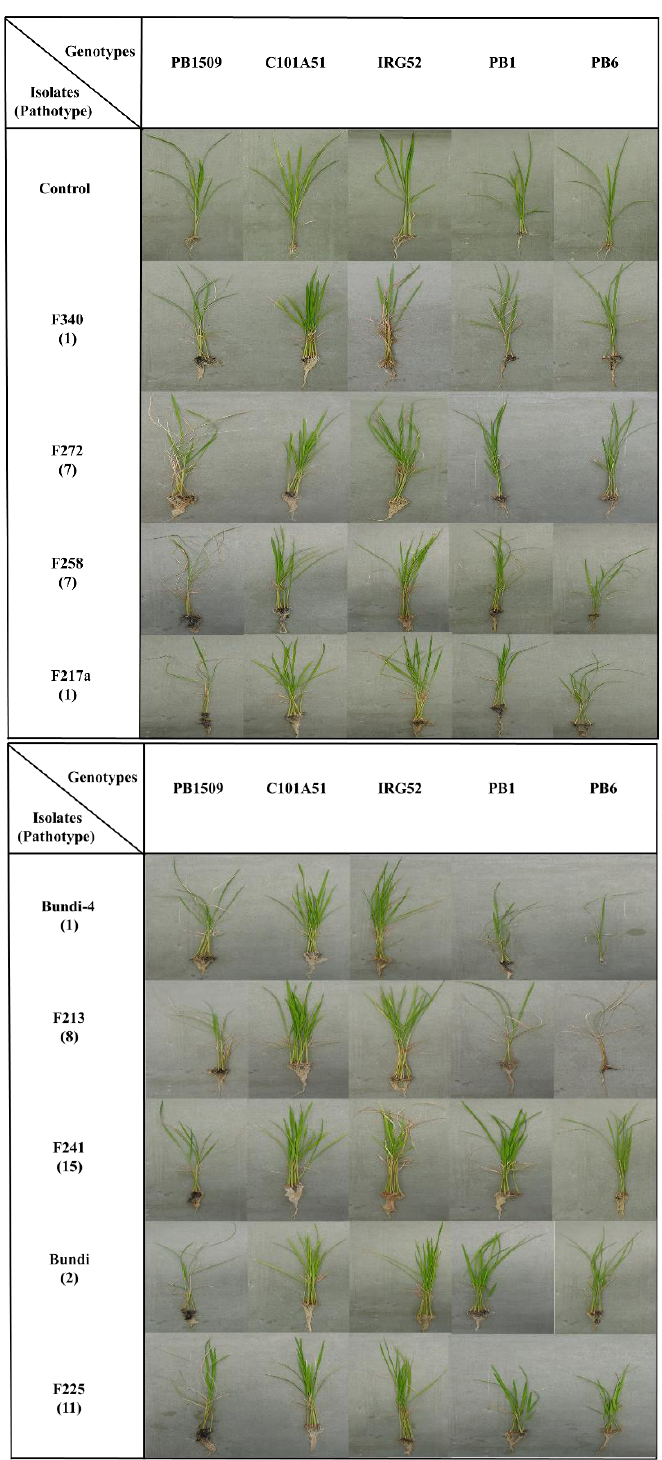
Figure 2. Representative isolates causing bakanae disease of rice in genotypes differing in their resistance and their corresponding pathotype group . Blackening of roots and drying of the plants can be observed in PB1509, PB1, and PB6, but C101A51 and IRG52 possess intact roots and green leaves. Pathotypes were classified based on the disease response of five rice genotypes differing in their resistance.